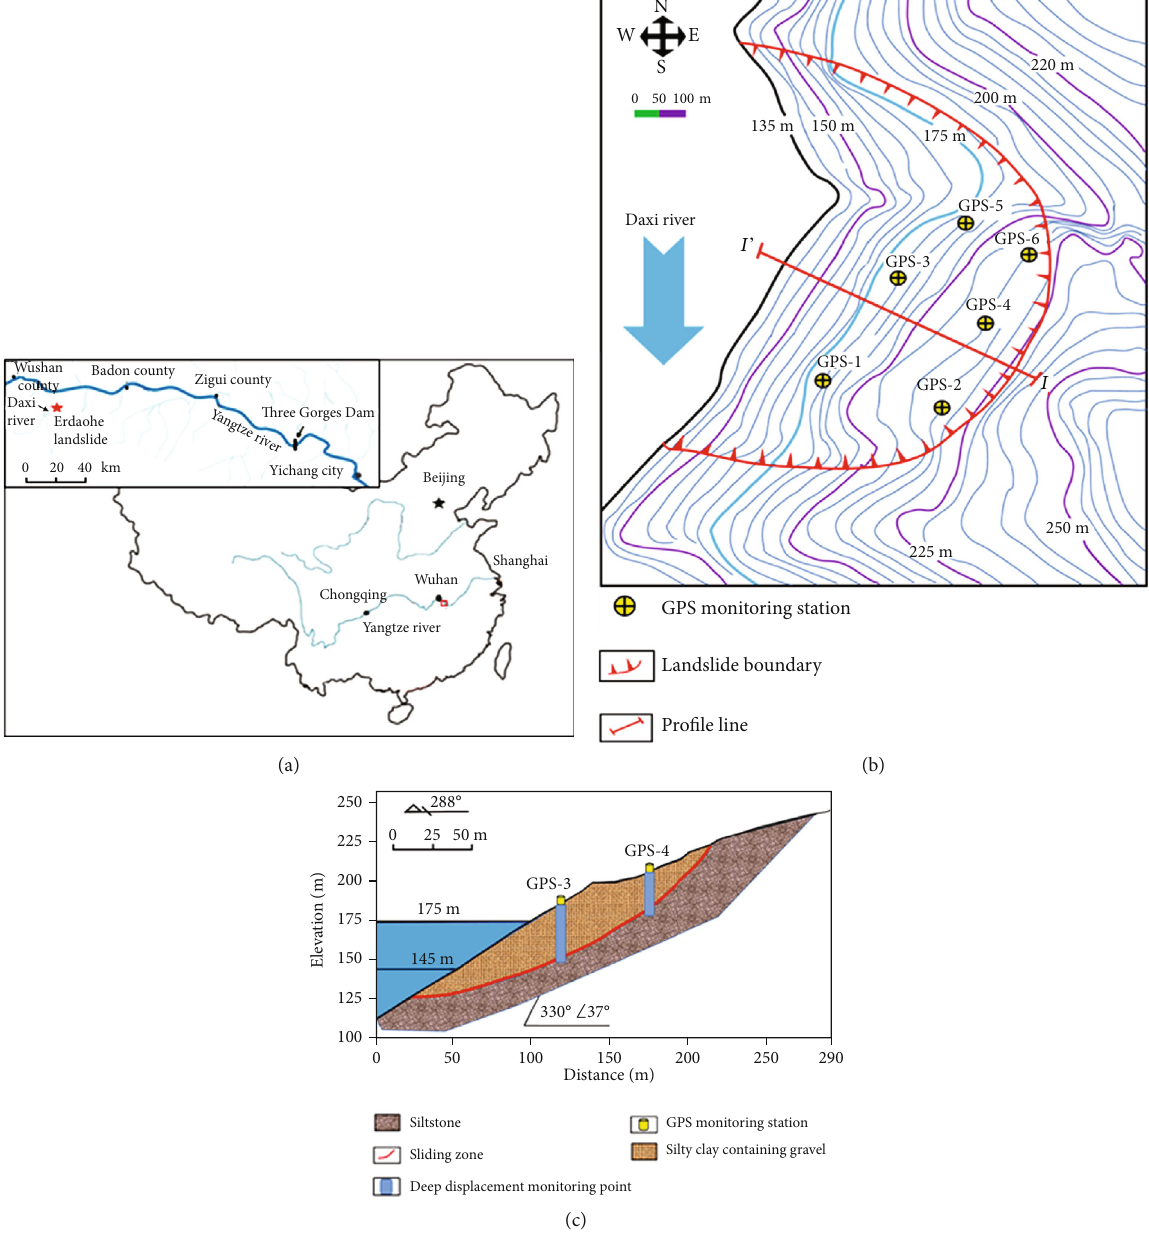
Figure 1: (a) Location of the Erdaohe landslide. (b) Floor plan of the Erdaohe landslide with monitoring. (c) Cross section along the I-I ′ pro fi